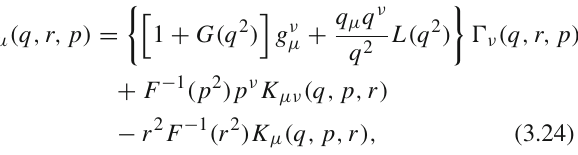
graph ( b ) relies on the fact that the term ( k + p ) ρ originating from the tree-level ghost-gluon vertex is contracted with an adjacent (cid:2) ρσ ( k ) in the Landau gauge, see Eq. (3.4). How- ever, if the (cid:2) ρσ enters, in its other end, into a tree-level vertex (cid:2) (cid:3) ( 0 ) , the longitudinal momentum ( k + p ) σ present in (cid:3) P will act on it; thus, the original ( k + p ) ρ will be contracted with ( k + p ) ρ /( k + p ) 2 instead, and will therefore survive when the limit p → 0 is taken.